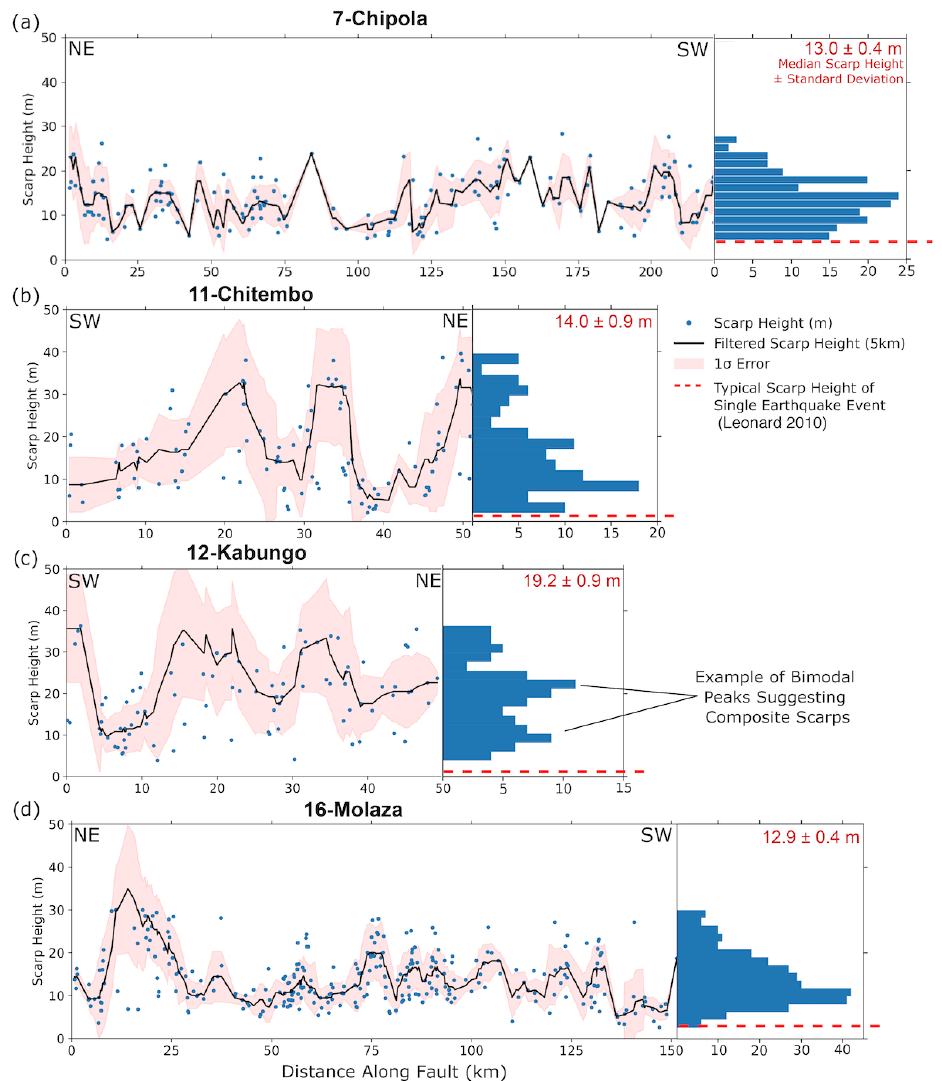
Figure 10. Along-strike fault scarp height profiles for four faults in the Luangwa Rift. Horizontal axis is not to scale but represents relative variations in fault length. Circles represent individual scarp height measurements, black lines show the 3km filtered moving median offset, and pink shading shows the 1 σ error. Histograms represent the frequency of scarp heights in the profile. Median scarp heights are shown in red with the uncertainty being the standard error. The dashed red lines represent the average single event displacement ( D av ) values for each fault derived from empirical relationships (Leonard, 2010). Scarp heights exceeding this, along with bi-modal histogram peaks, suggest the potential for multiple earthquake events and composite scarps. These data have been archived and are available at the following location: https://doi.org/10.5281/zenodo.6513545 (Turner et al.,